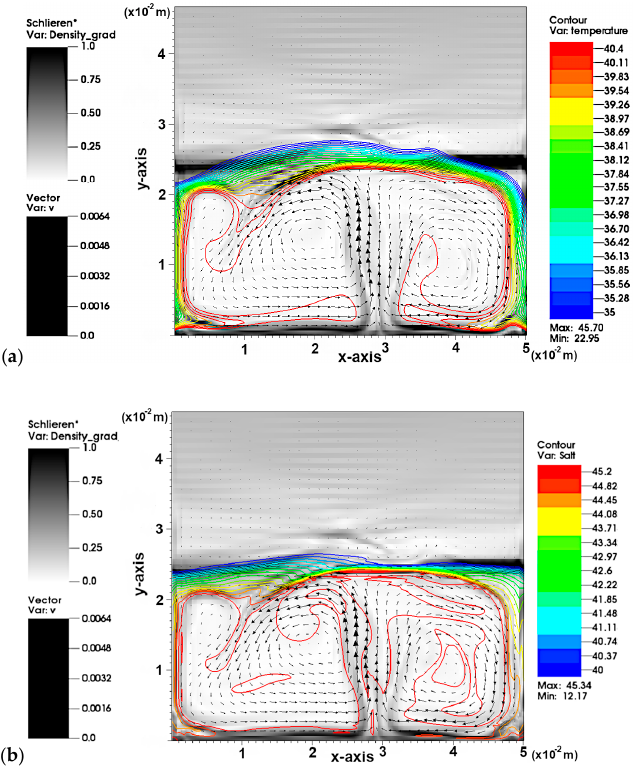
Figure 6. Schlieren image at t = 1070 s overlayed with the predicted velocity field and ( a ) temperature contours or ( b ) salinity contours. The system continues to evolve with the sporadic appearance of disturbances, such as that shown in Figure 5. Figure 7 illustrates the stratification mechanism due to double diffusion with side cooling at t = 2470 s. It leads to two new thin but well-defined convec- tive zones, CZ1 and CZ2, which appear between the LCZ and the NCZ, and whose height is similar, while the height of the LCZ has increased, as expected. Vortices close to the left